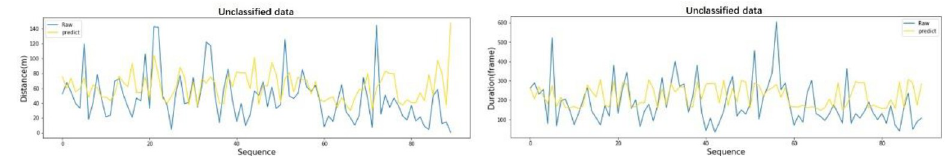
Fig 13. Prediction results of the weaving model without classification.